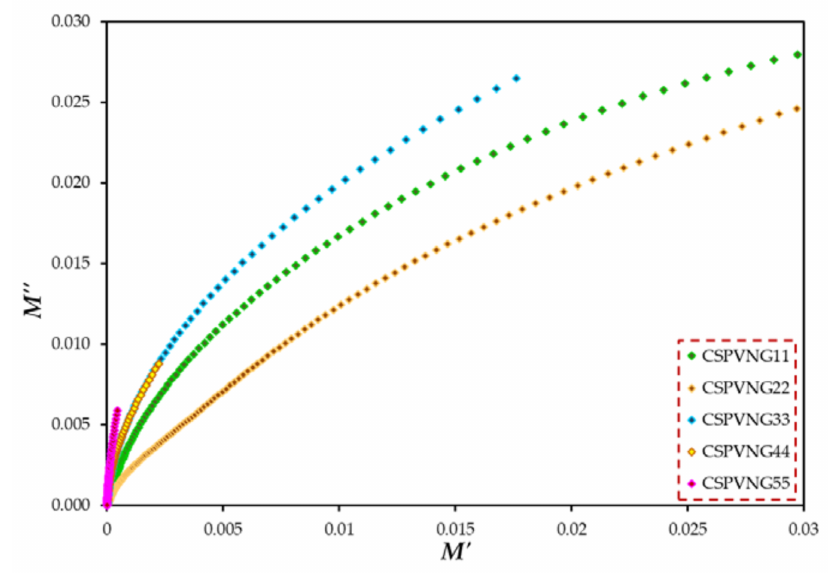
Figure 14. M (cid:48)(cid:48) -M (cid:48) plot for all plasticized SPE